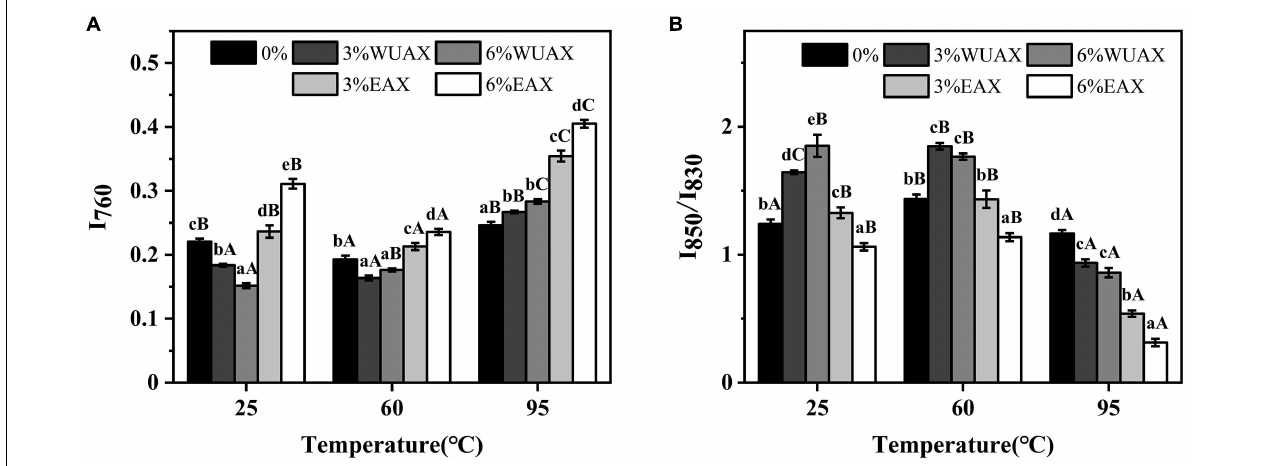
FIGURE 2 | Effect of WUAX and EAX on the tertiary structure content of gluten: (A) I 760 and (B) I 850 /I 830 . 3%WUAX, gluten with 3% (w/w) WUAX; 6%WUAX, gluten with 6% (w/w) WUAX; 3%EAX, gluten with 3% (w/w) EAX; 6%EAX, gluten with 3% (w/w) EAX.